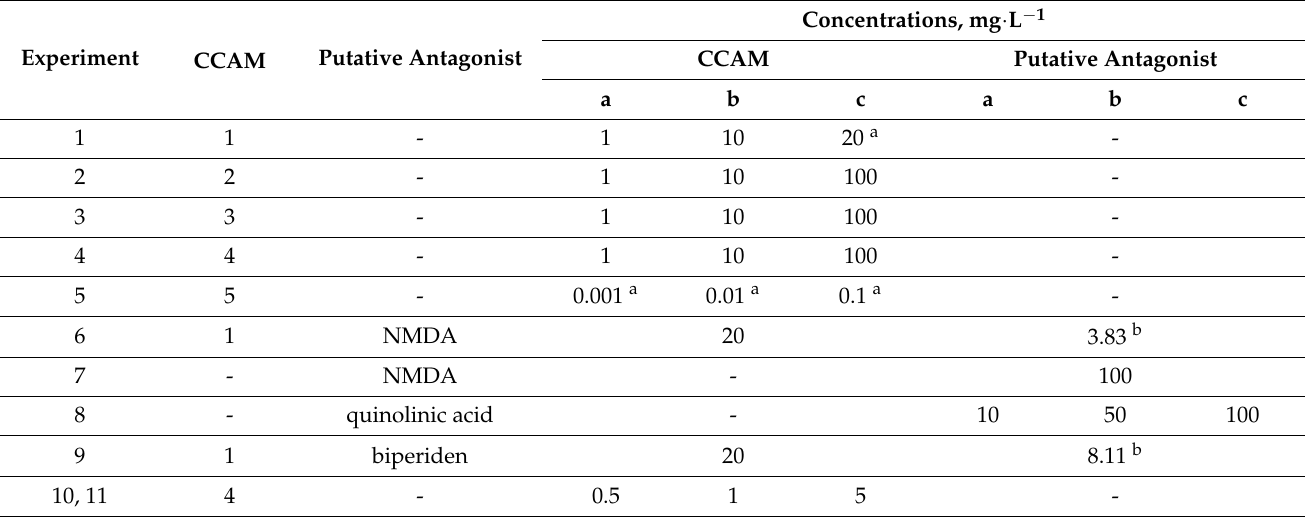
Table 2. Working concentrations of all agents used in the